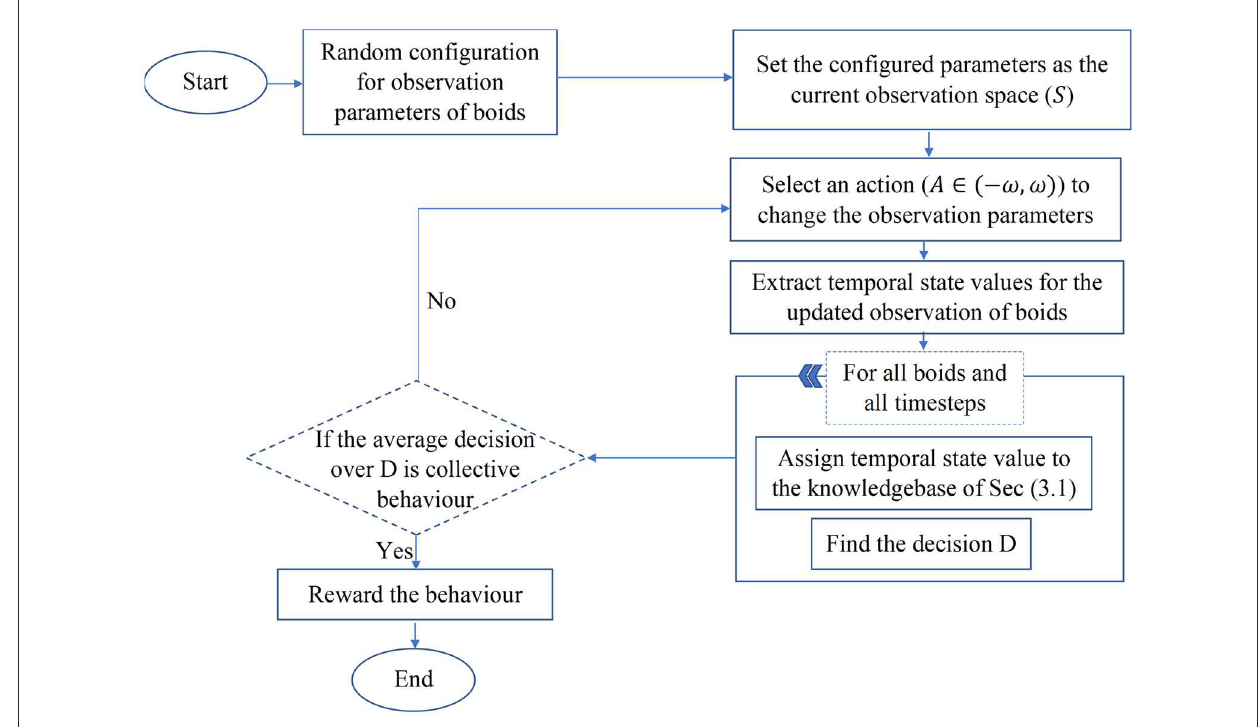
FIGURE2 Flowchart of the CoMoT learning